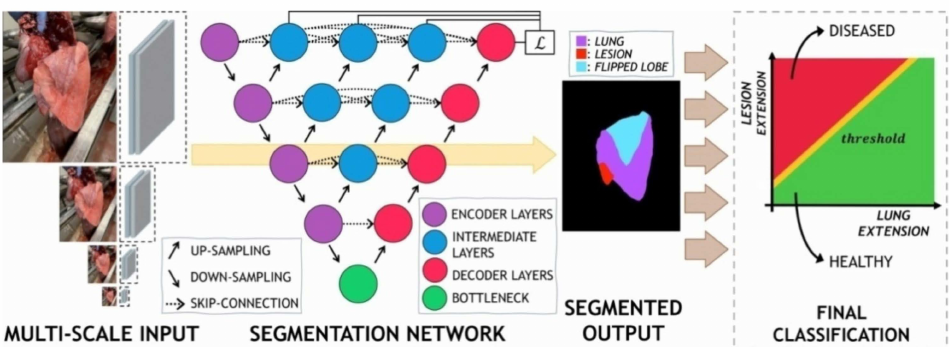
Figure 3. Architecture of the DL-based model employed. The input is scaled to multiple resolutions and pre-processed before being fed to the main network. The segmentation masks delivered can be conveniently depicted as an RGB image by assigning a color to each class (red, purple, blue). The final score is computed as the ratio between the number of pixels belonging to the class “lesion” and those belonging to the combined classes “lung + lobe” (i.e., the entire pulmonary